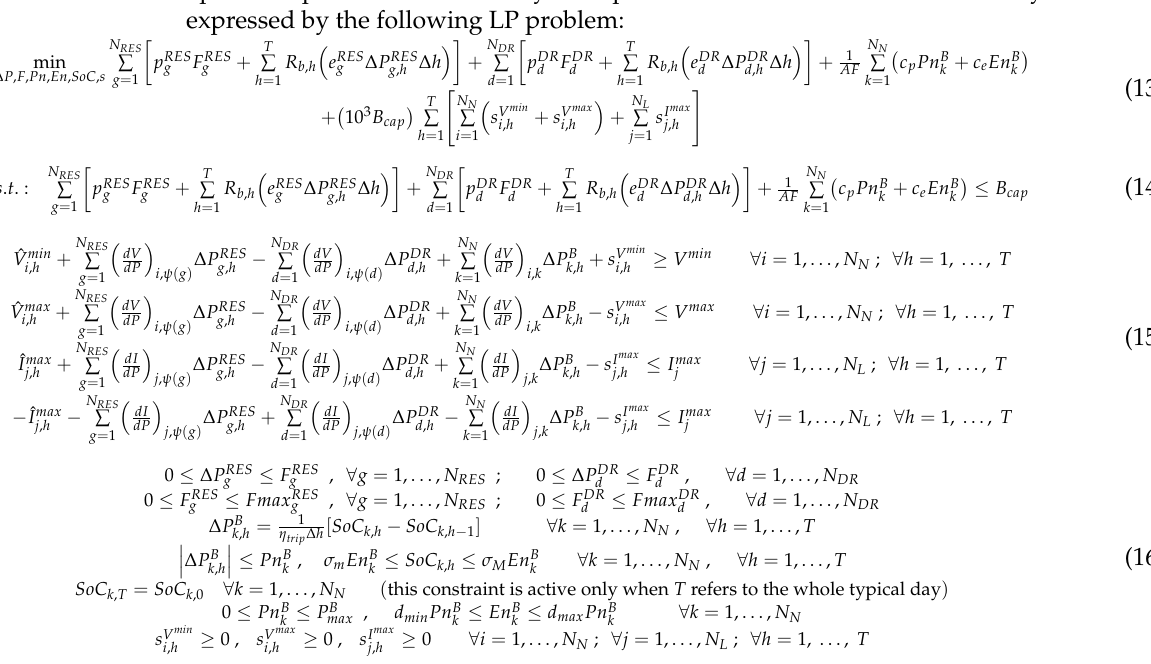
Figure 4. Assessment of the residual probability of technical constraints violation ( p *tcv ) .